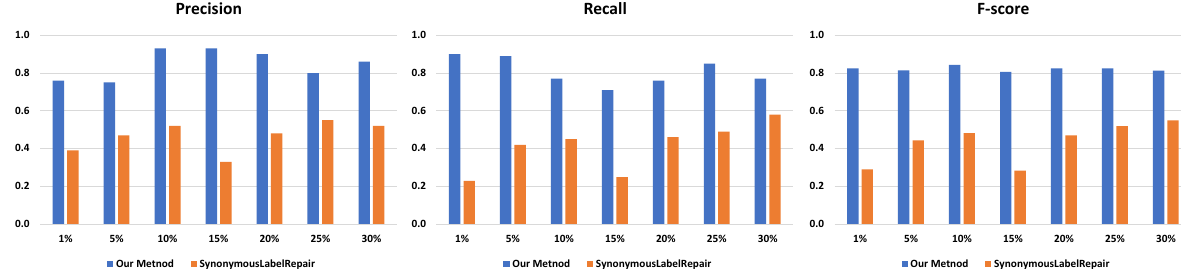
Figure 7. Comparison of our framework with the baseline using the Sepsis event